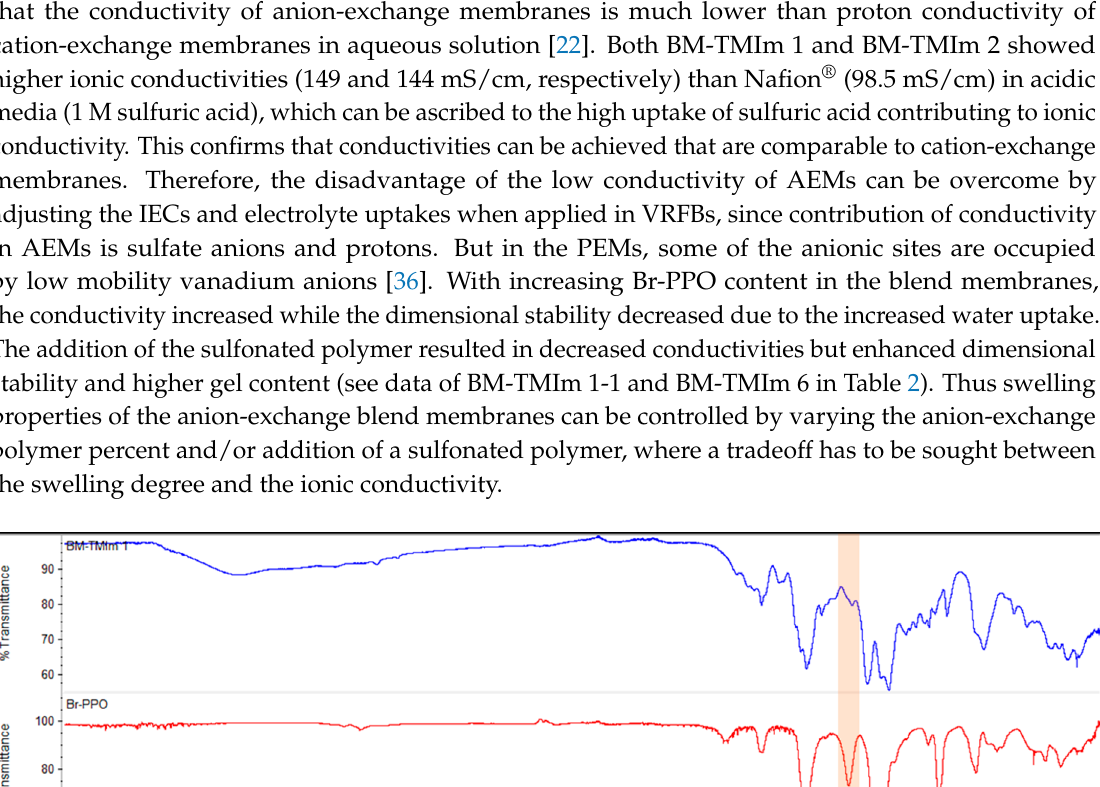
Table 2. The properties of anion-exchange blend membranes.